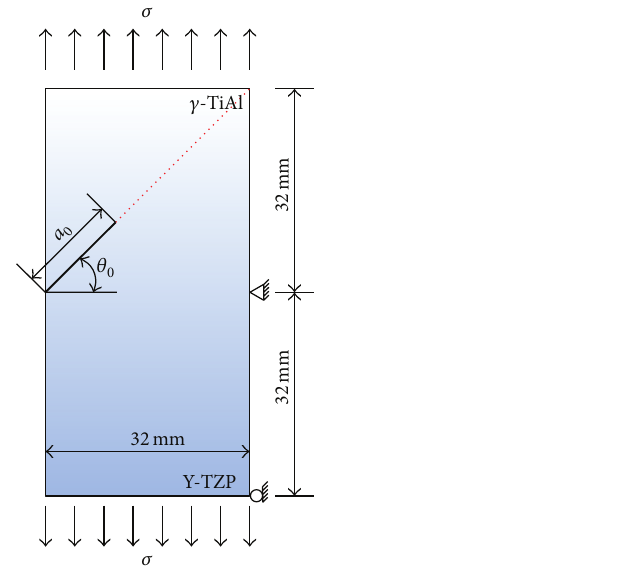
was employed, without encountering convergence